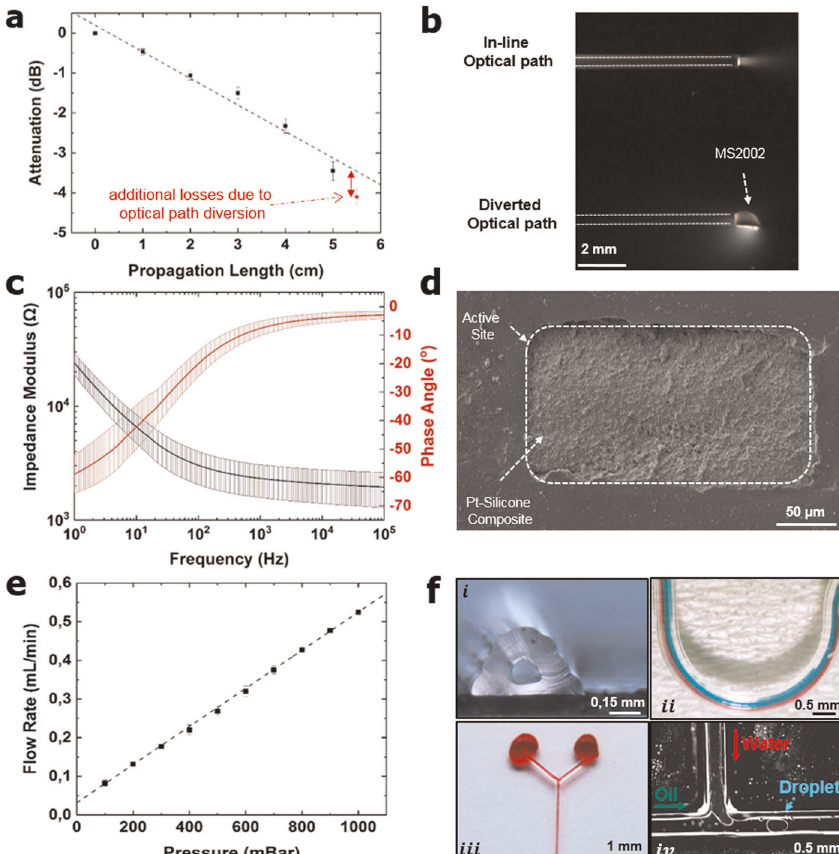
Fig. 3 Characterization of freeform functional fi bres. a Optical attenuation of blue light (470 nm) along the length of optical fi bres. The loss due to diverting light at the contact site is indicated in red ( n = 5). b Optical photographs, demonstrating light emission from a straight terminated optical fi bre and an optical fi bre terminated with a contact site. Fibres are immersed in a solution of colloidal particles (milk). c Impedance spectra of printed electrodes immersed in phosphate-buffered saline (PBS) ( n = 5). d Scanning electron micrograph (top view) of the contact site of a typical printed electrode. e Hydrostatic resistance of a printed micro fl uidic fi bre. Fibre length and lumen diameter are 44 mm and 135 µm, respectively ( n = 5). f Micrographs of various fl uidic fi bre designs. Cross-section of a fl uidic fi bre illustrates the characteristic pyramidal shape of the structure (i). Freestanding fi bres can be printed in curved shapes and support laminar fl ow inside the lumen (ii). Demonstration of a bifurcated micro fl uidic fi bre eluting food dye from two outlets (iii) and a T-shaped junction for production of micro-droplets